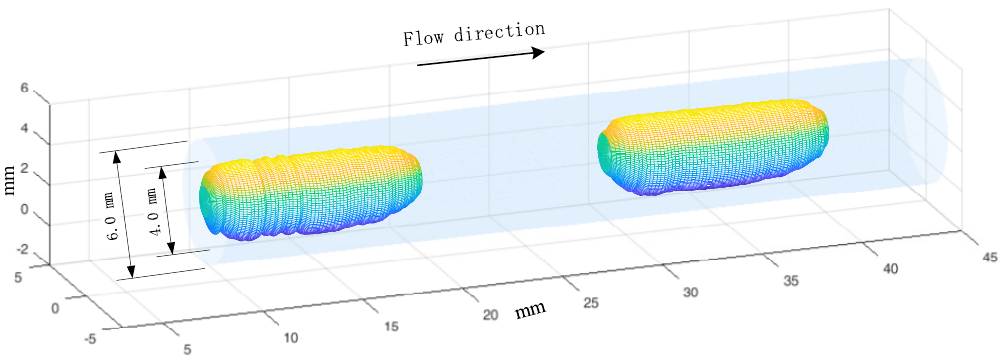
Figure 14. 3D reconstruction results of slug flow (velocity 0.42 m/s, void fraction 0.61).